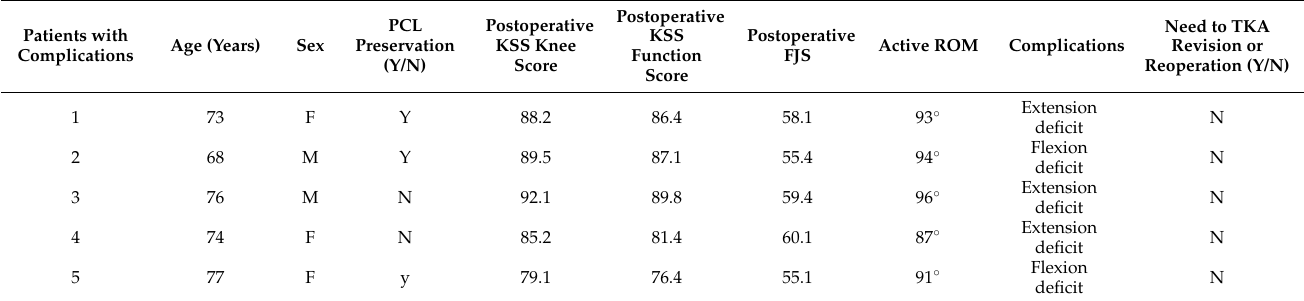
Table 5. Complications after KA